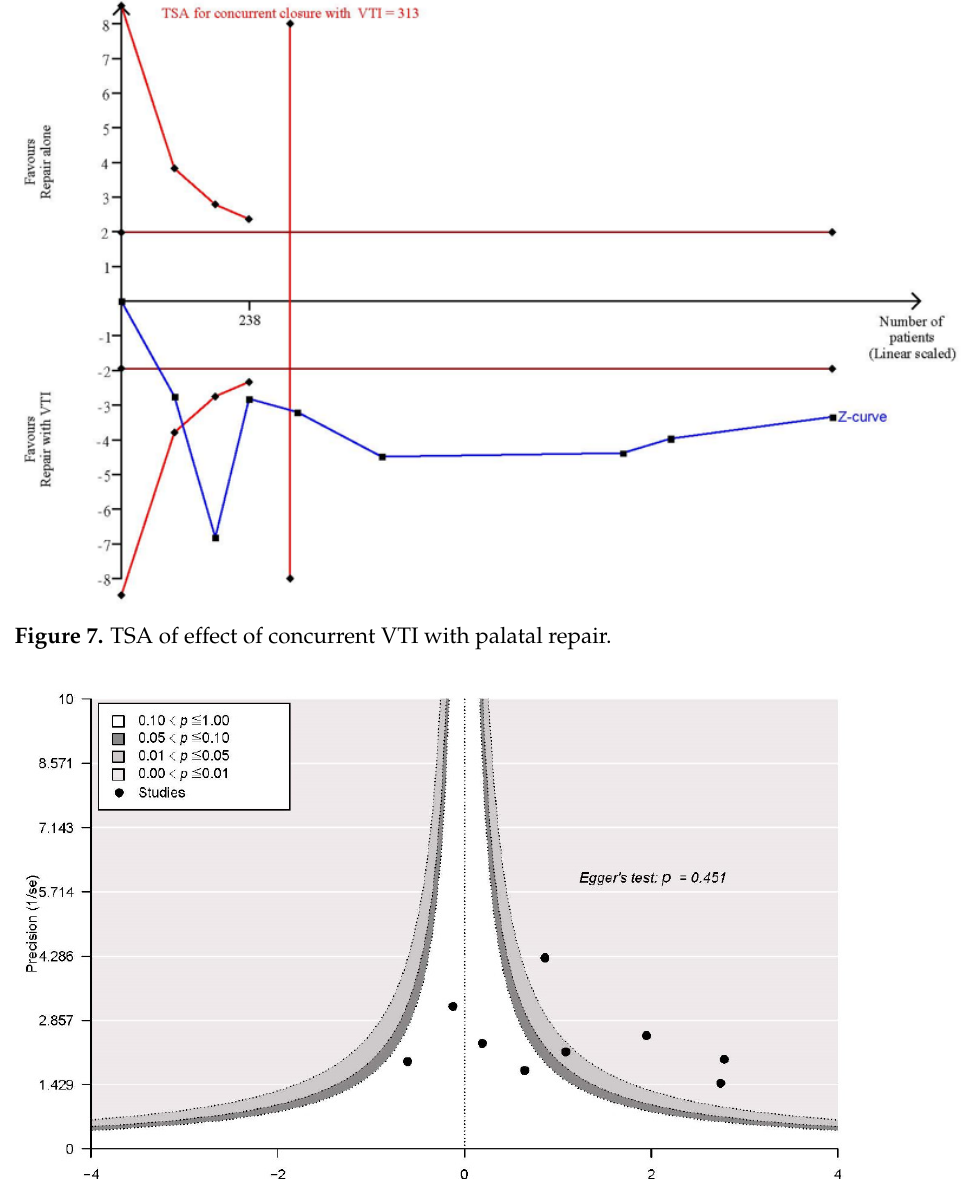
Figure 8. Funnel plots with Egger’s test for publication